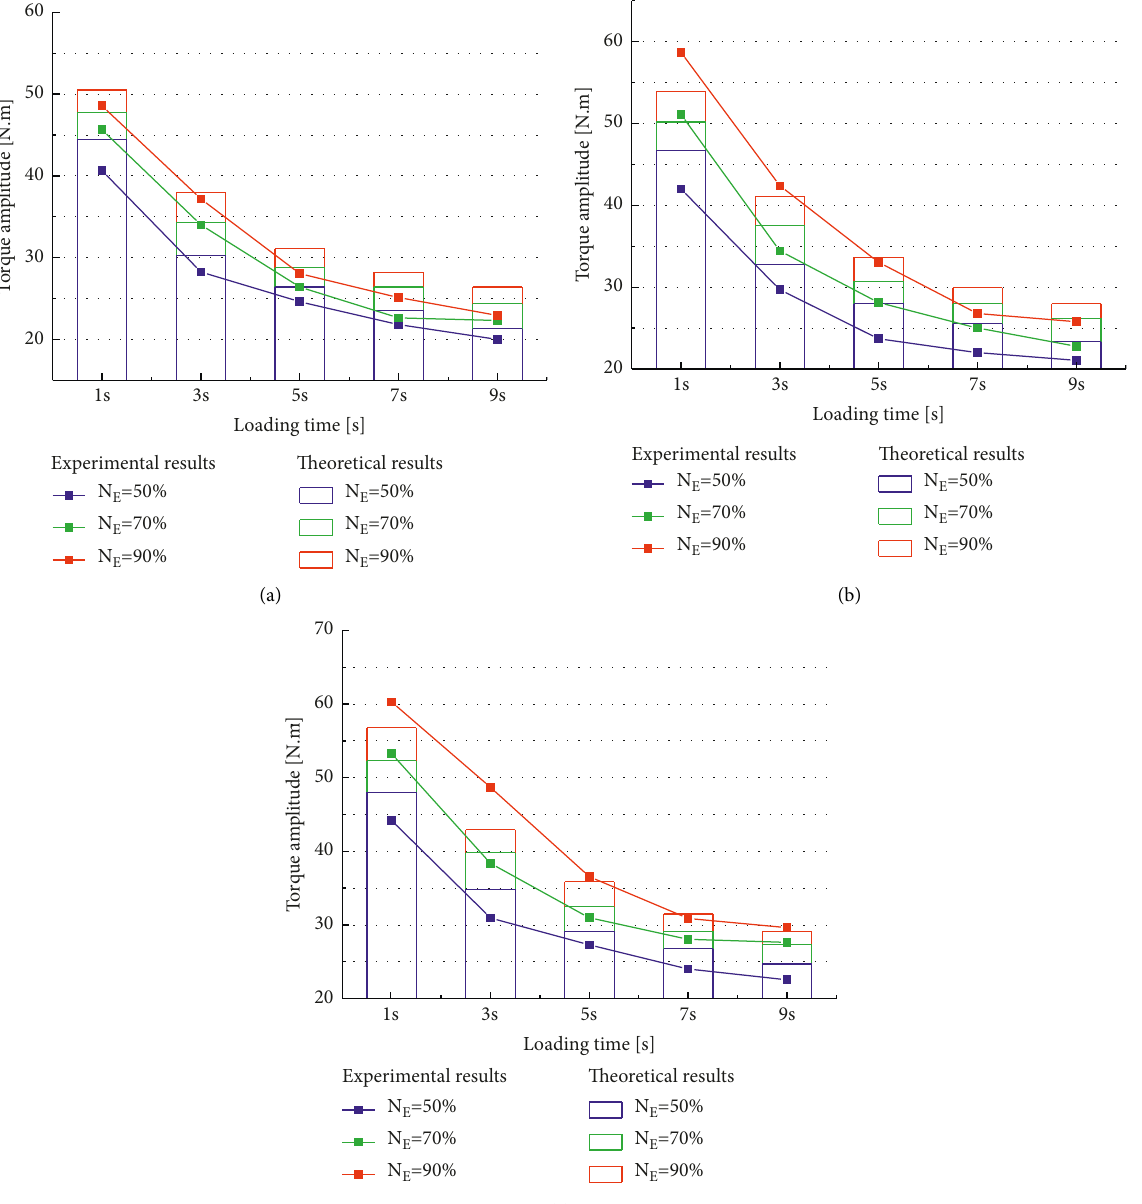
� 50%, (b) N � 70%, and (c) N � R R R